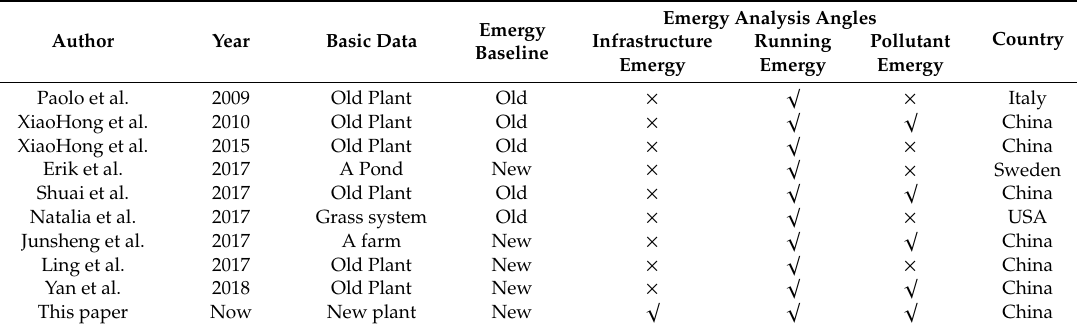
Table 1. Comparison of existing articles in the sewage treatment industry based on